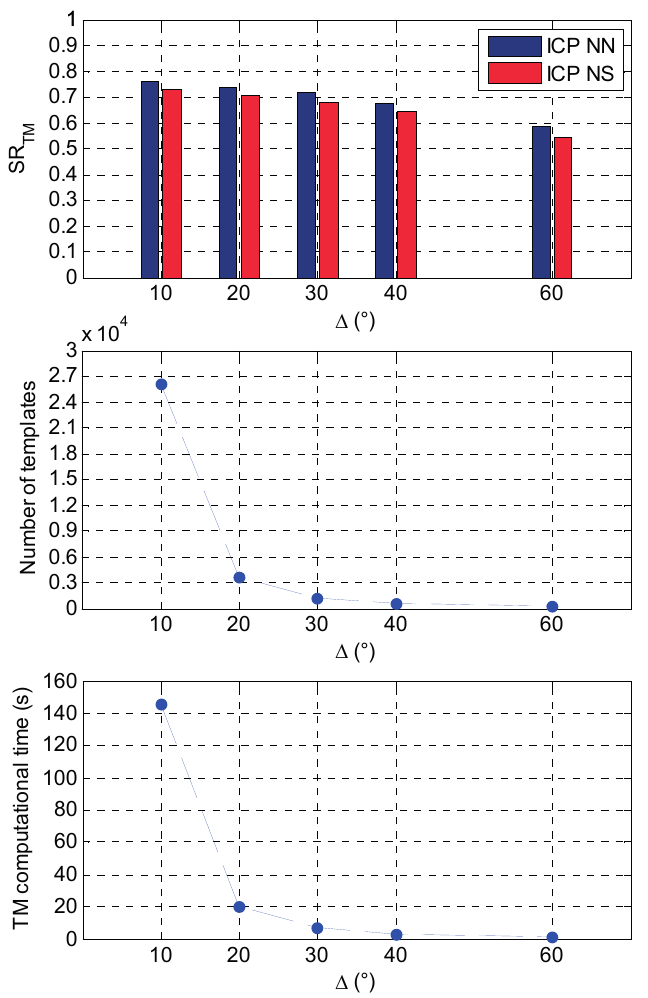
Figure 6. ( Top ) Effect of Δ on SR TM comparing the NN and NS approaches. ( Center ) Effect of Δ on the number of templates to be generated; ( Bottom ) Effect of Δ on the average computational